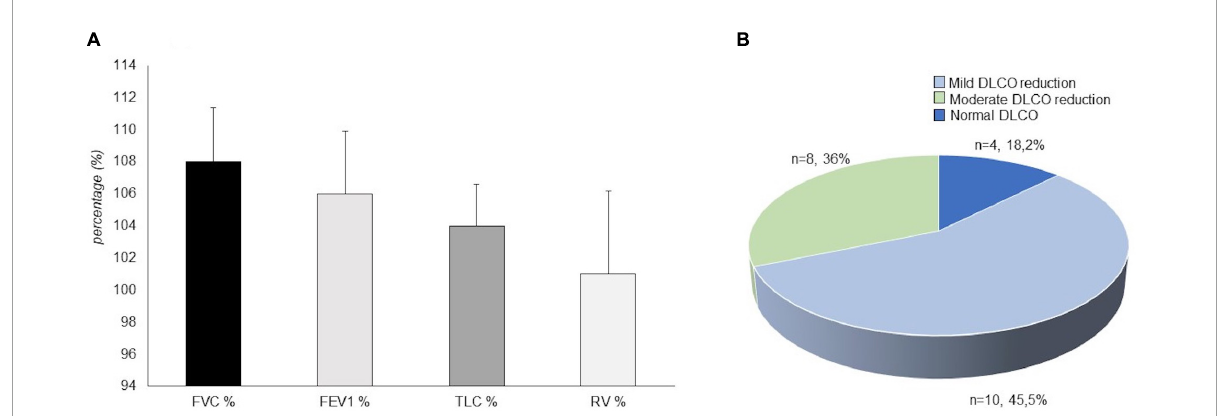
FIGURE2 Mean value of spirometry parameters in our patients with primary Sjögren’s syndrome (pSS) ( N = 22). FVC%, Vital capacity forced expressed in a percentage value of the theoretical; FEV1%, Forced expiratory volume in the first second expressed in a percentage value of the theoretical; TLC%, total lung capacity expressed in a percentage value of the theoretical; RV%, Residual volume expressed in a percentage value of the theoretical (A) . Diffusing capacity of the lung for carbon monoxide (DLCO) outcome in our patients with primary Sjögren’s syndrome ( N = 22). In total, four patients (18.2%) showed a normal pattern, 10 patients (45.5%) showed a mild degree deficit, eight patients (36%) showed a moderate degree deficit (B) .